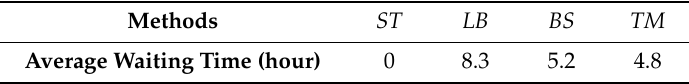
Table 6. Average waiting time of batch-type jobs on a sunny day.